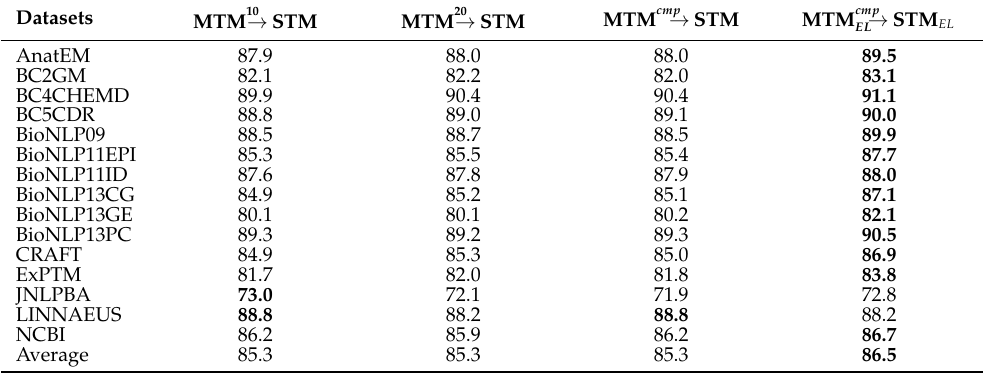
Table 10. Results comparison of transfer Learning for different models with and without ELMo.